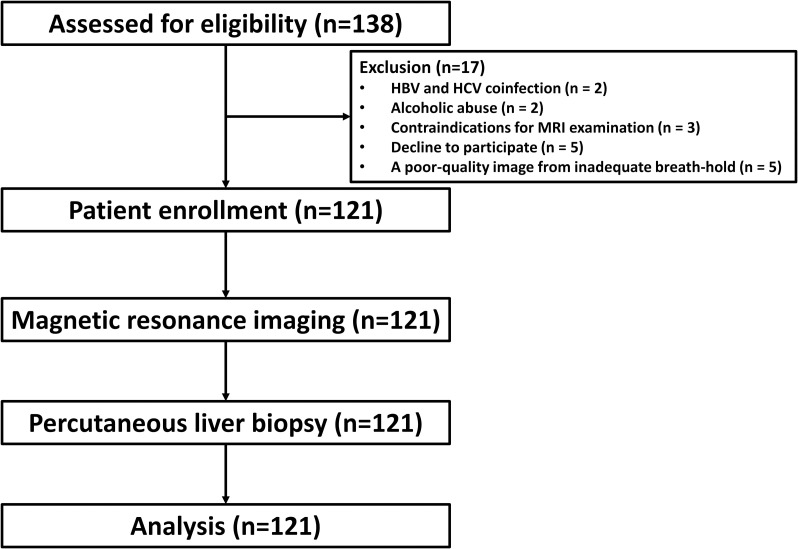
Flow diagram of the trial.